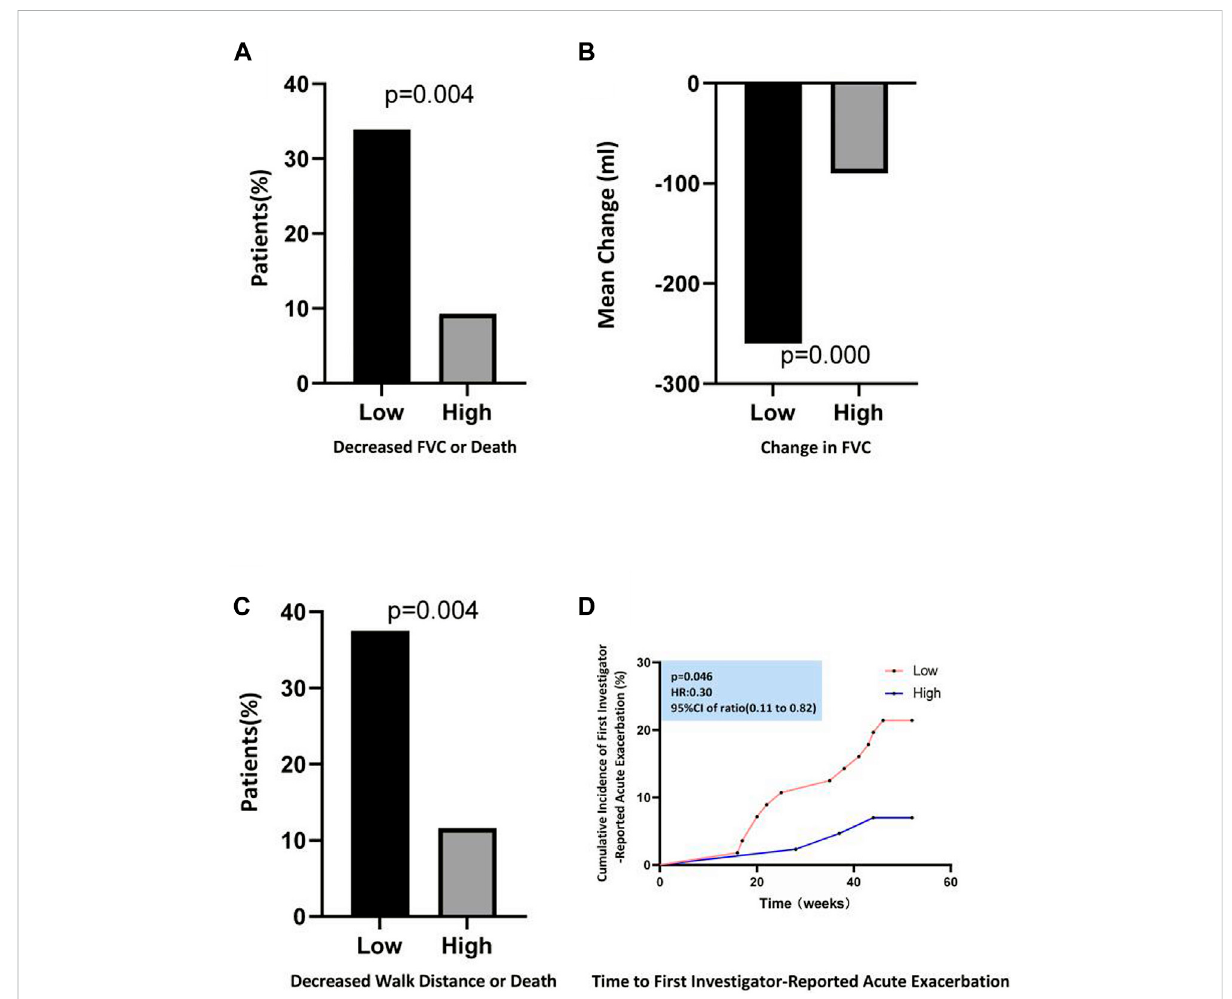
Ef fi cacy Outcomes during the 52-Week Study Period. (A) Shows the proportion of patients who had a decreased percentage of the predicted FVC ≥ 10% or who died. (B) Shows the mean change from baseline in FVC. (C) Shows the proportion of patients who had a decline of 6-min walk distance ≥ 50 m or who died. (D) Shows the Kaplan – Meier distribution for the probability of time to fi rst investigator-reported Acute Exacerbation.